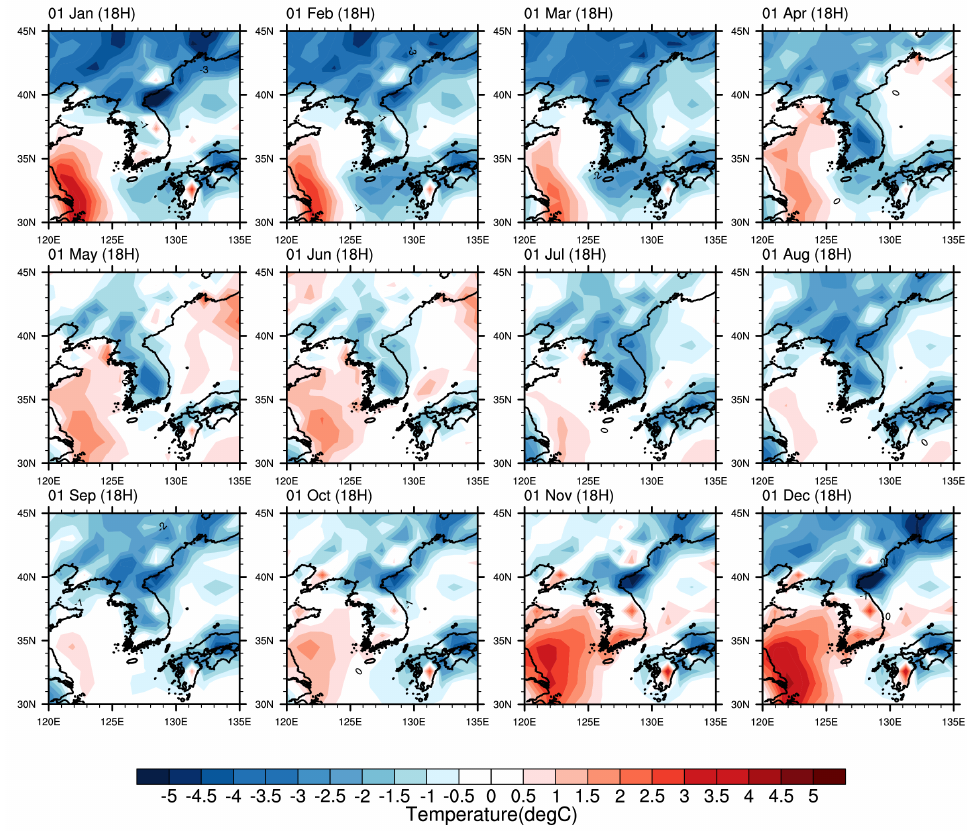
Figure 1. Twelve -year (1999–2010) mean bias (CFSv2–ERA5) during 14~45 days for 2 m temperature, where the initial time is the first day of each